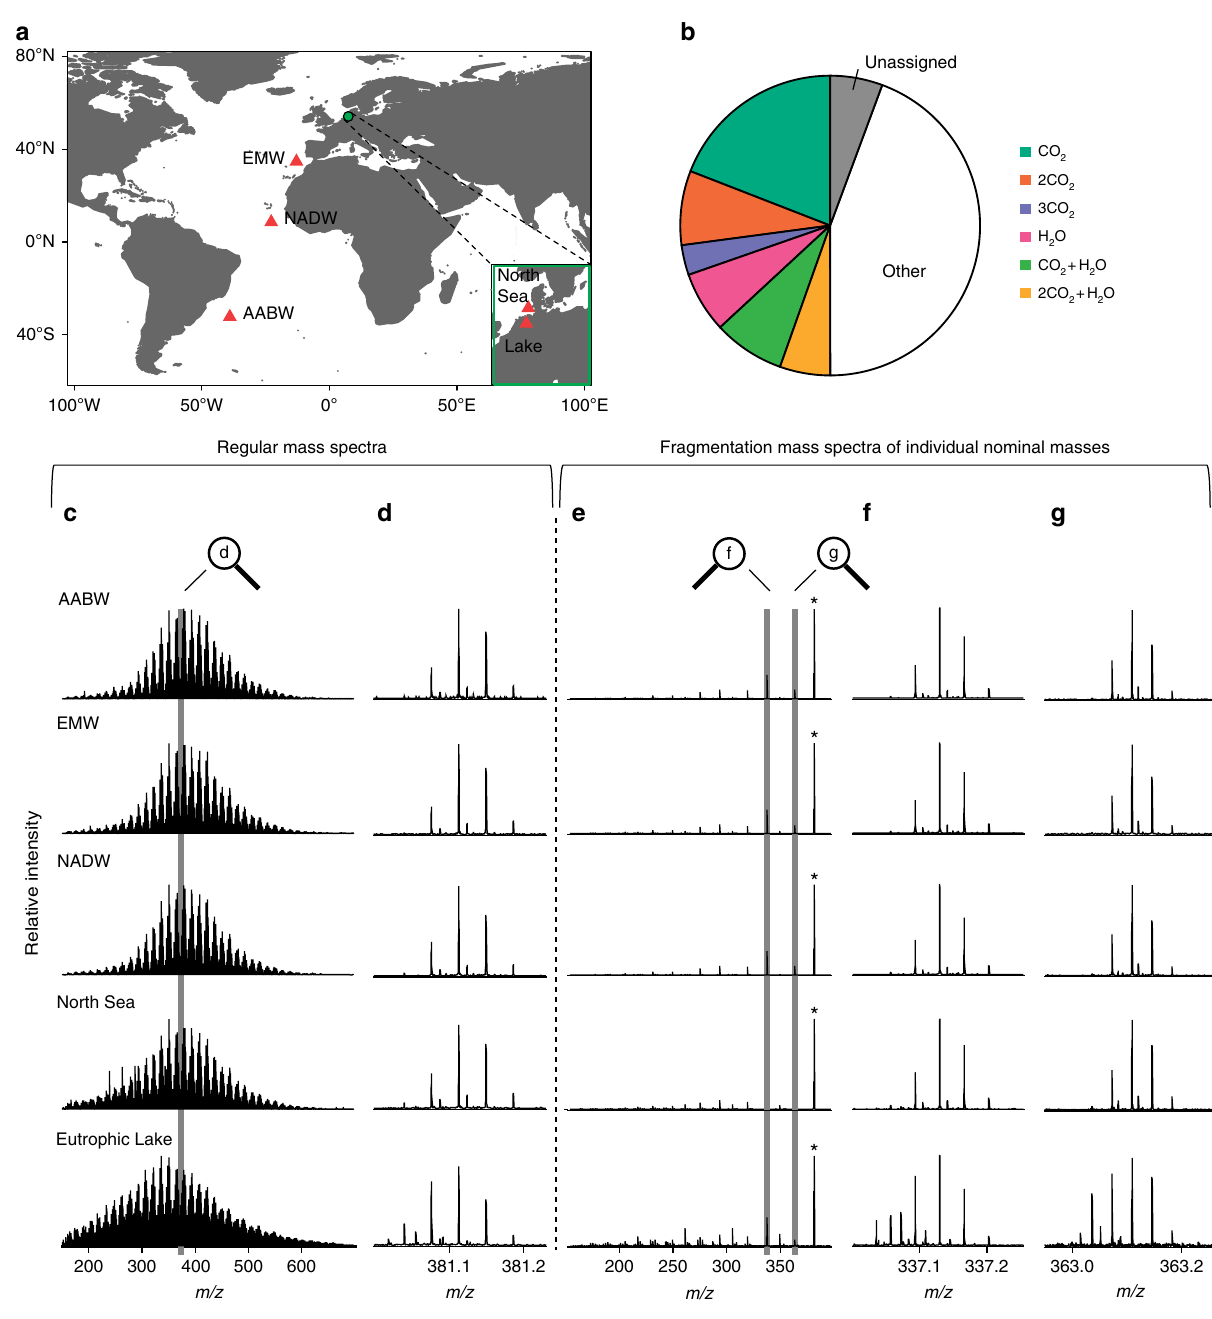
Fig. 1 FT-ICR mass spectra of DOM samples, broad band scans and fragmentation experiments. a Map of sampling sites 53 . b Most abundant fragment ions occurring in dissolved organic matter (DOM) fragmentation experiments as percentage of total intensity (named according to the corresponding neutral loss). c Full range mass spectra showing bell-shape intensity distribution of detected masses. d Detected ions with nominal mass m / z 381 zoomed in from full range mass spectra, exemplary for the six fragmented nominal masses. e Full fragmentation patterns of m / z 381, exemplarily. f Fragment ions resulting from neutral loss of CO 2 and g from neutral loss of H 2 O, zoomed in from the respective mass range in full fragmentation pattern. Precursor ions are indicated by asterisks